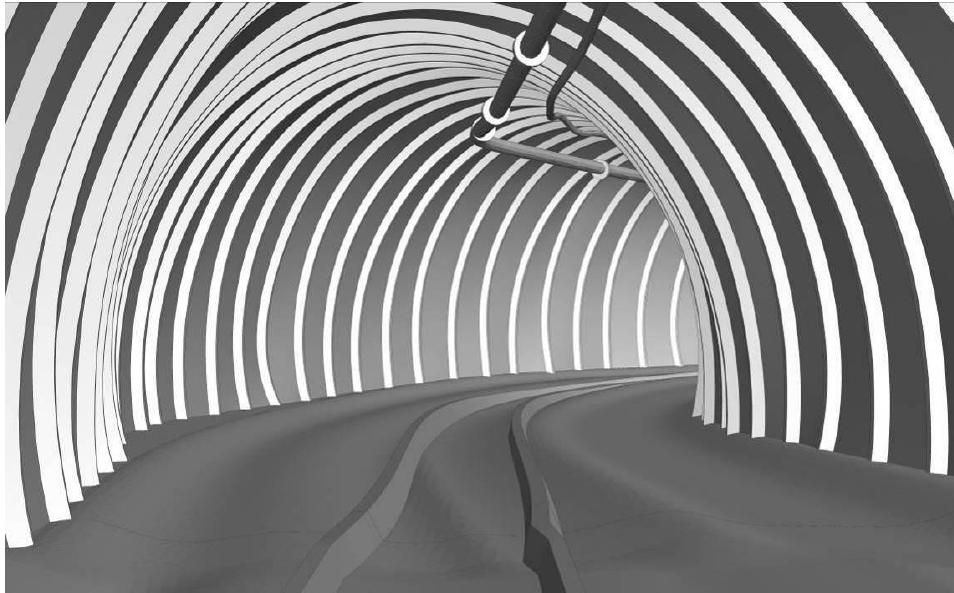
Figure 8. Obtained geometry model, view of the mine tunnel straight section near the bend.